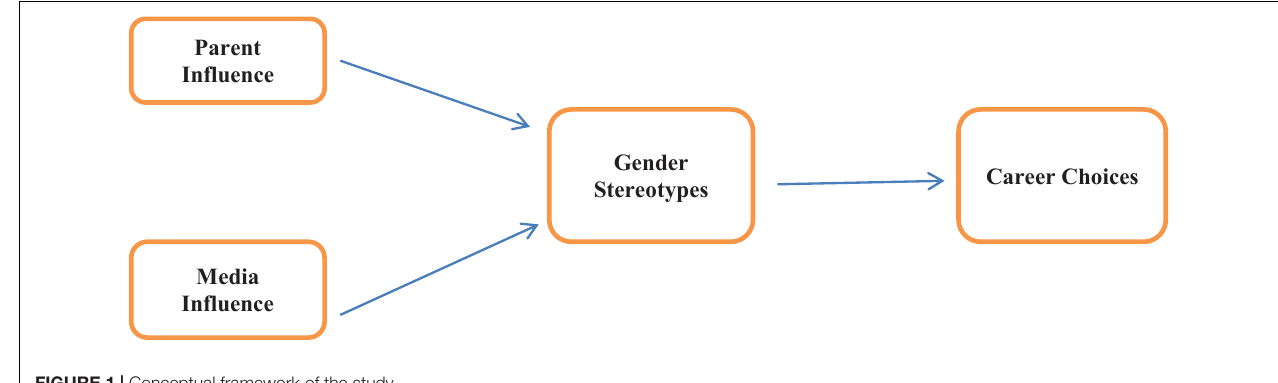
FIGURE 1 | Conceptual framework of the